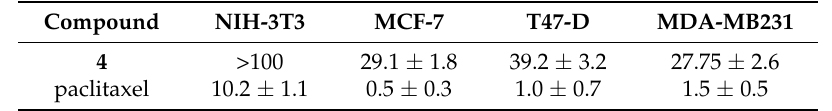
Table 1 . In vitro cytotoxic activities (IC 50 ) a,b of synthesized compound 4 . Table 1. In vitro cytotoxic activities (IC 50 ) a,b of synthesized compound 4